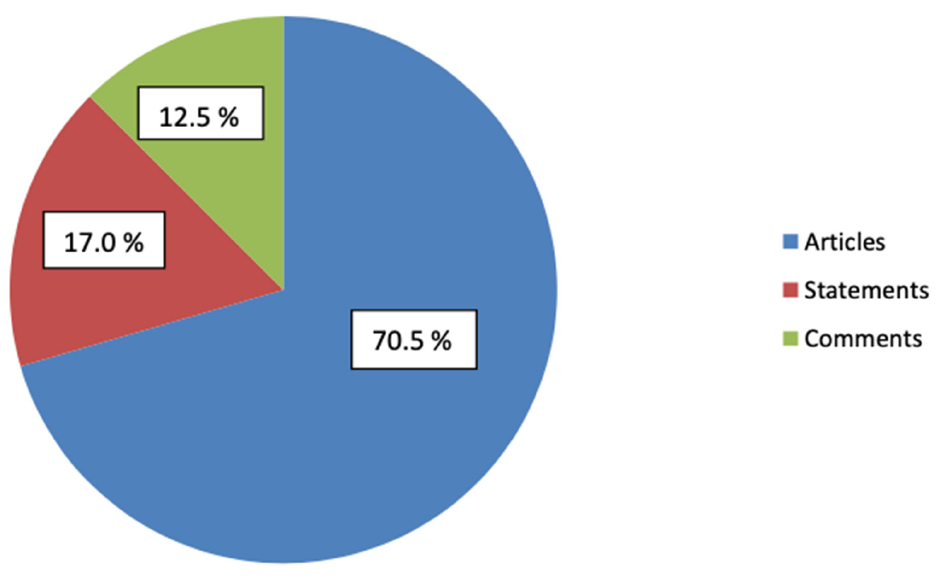
Figure 3. Division of the texts into subgroups. Table 3. Basic social media statistics of the included material.